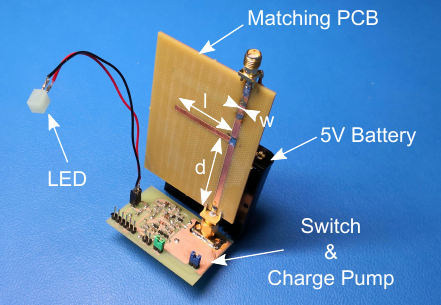
Figure 4. PCB (printed circuit board) prototype of the proposed system. An LED is used as the load, driven by a 5V battery. The microstrip stub tuner (matching network) is mounted to the CP (charge pump) via a SMA